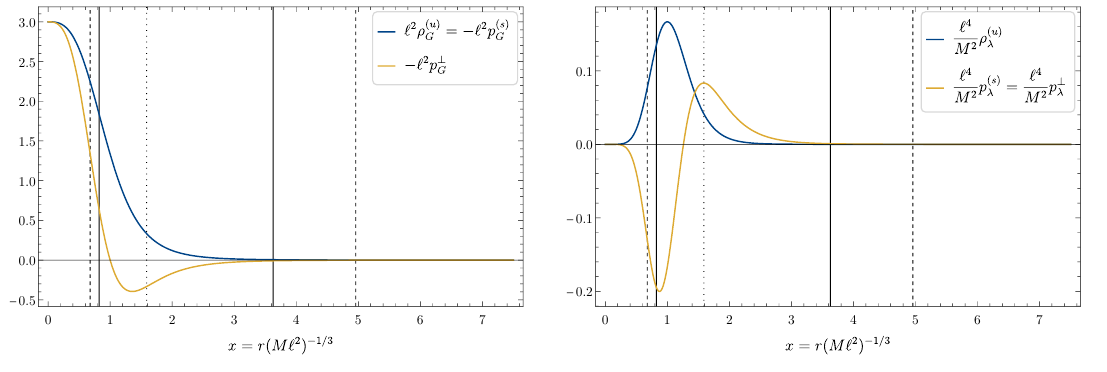
Figure 4. Components of the energy density and the principal pressures, as measured by an observer comoving with the æther, for the Hayward non-singular configuration in the minimal theory α = β = 0 . The position of the horizons in this coordinate strongly depends on ‘ : the vertical black lines mark UH (solid) and KH (dashed) for ‘ = 0 . 25 M ; the dotted line corresponds to the star’s effective radius (which coincides with the degenerate KH in the extremal